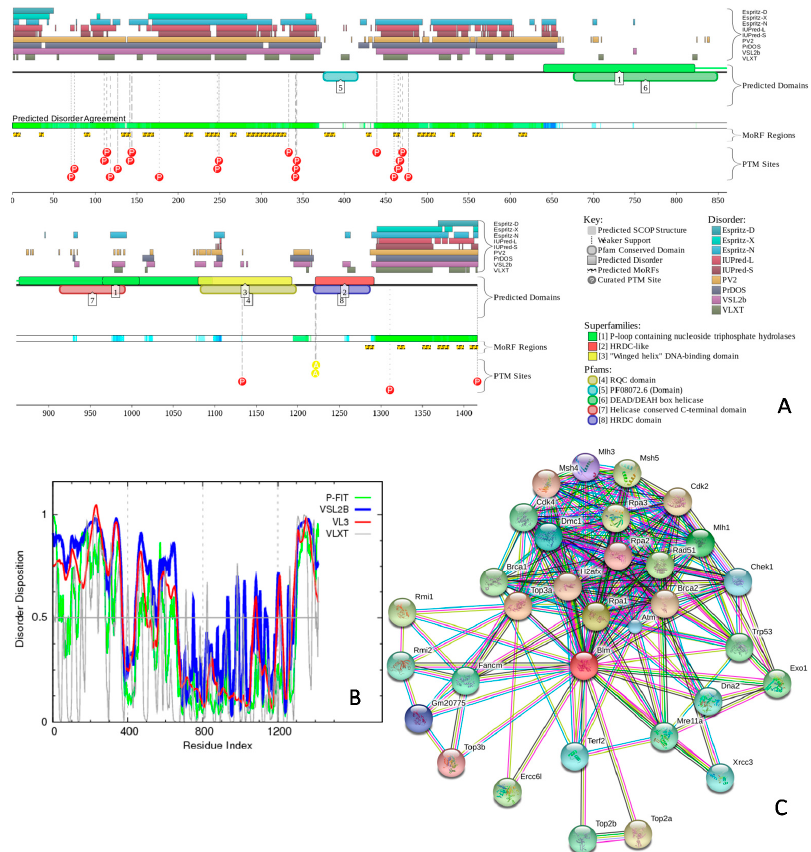
Figure 7. Functionality and prevalence of intrinsic disorder in the bloom syndrome protein homolog (UniProt ID: O88700). ( A ) Evaluation of the functional intrinsic disorder propensity by the D 2 P 2 database (http://d2p2.pro/) [55]. In the corresponding plot, the colored bars at the top are representative of the location of disordered regions obtained from different disorder predictors (including IUPred-L, IUPred-S, Espritz-D, Espritz-N, Espritz-X, PONDR ® VSL2b, PONDR ® VLXT, PV2, and PrDOS). Location of predicted and known domains are shown by numbered colored bars. The white-and-green portion displays the agreement in the predicted disorder among the aforementioned predictors, with green parts indicating regions that are disordered by consensus. The yellow bar indicates the location of the predicted disorder-based binding site (MoRF region), whereas red circles with “P” inside and yellow circles with “A” inside at the bottom of the plots show locations of phosphorylation and acetylation sites, respectively. Vertical dashed lines show actual positions of these phosphorylation and acetylation sites; ( B ) Evaluation of the per-residue disorder propensity based on predictors from the PONDR family. A thin line at a score of 0.5 represents the disorder threshold between disorder (>0.5) and order (<0.5); ( C ) Analysis of the interactivity of the nuclear pore complex-associated intra-nuclear coiled-coil protein TPR (UniProt ID: Q7M739) by STRING computational platform [78]. STRING produces the network of predicted associations for a particular protein and its interactome. The nodes in this network are proteins, while the predicted or known functional associations are the edges. When predicting the associations, seven types of evidence are used, which are indicated in the resulting network by the differently colored lines. Here a green line represents neighborhood evidence; a red line—the presence of fusion evidence; a purple line—experimental evidence; a blue line—co-occurrence evidence; a light blue line—database evidence; a yellow line—text mining evidence; a black line—co-expression evidence [78].